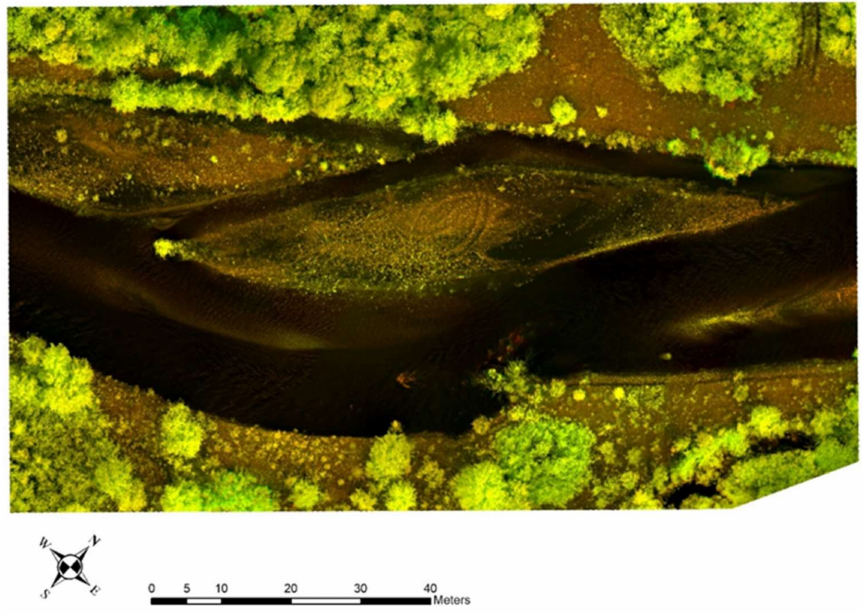
Figure 4. Instance of first testing composite bands orthophoto; these rasters were obtained merging the red-edge and the NIR